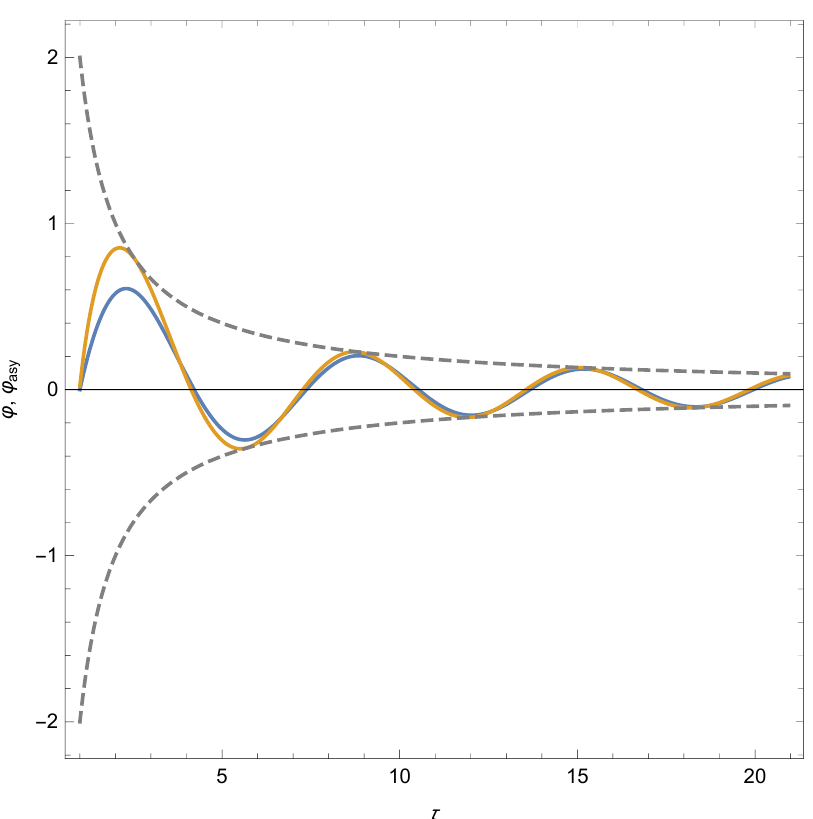
Figure 1. Numerical integration (blue line) with initial conditions ϕ ( 1 ) = 0, ϕ (cid:48) ( 1 ) = 1 and leading term of the asymptotic expansion (brown line) for the differential Equation (21) corresponding to the quadratic potential. The dashed lines are the envelopes ± 2/ τ that set the scale for the generalised asymptotic expansion